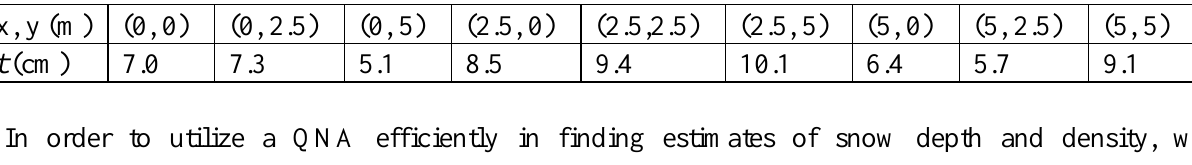
Table 1. Nine snow depth ( t ) measurements taken from the base of the ground reflector using a ruler. One corner location is assigned the origin value of (0, 0) in (m). The measured snow depth range is 7.6 cm  2.5